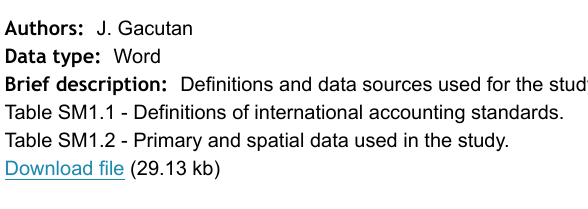
Table SM1.1 - Definitions of international accounting standards. Table SM1.2 - Primary and spatial data used in the